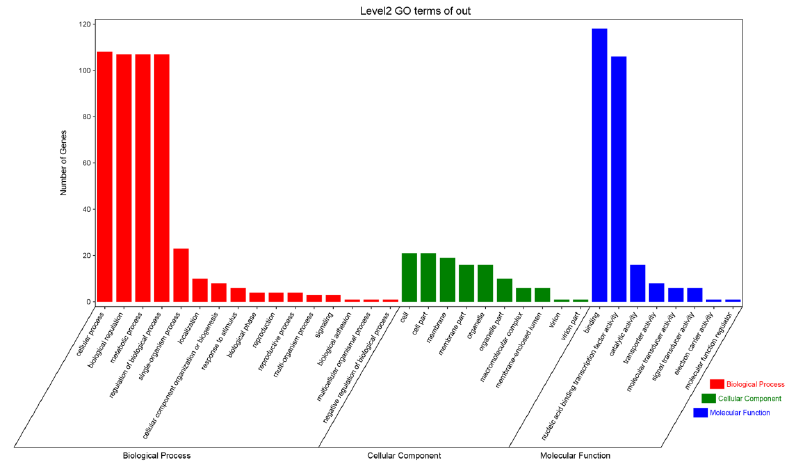
Figure 2. Gene Ontology (GO) enrichment of MdWRKY gene family. Table 1. Significantly differentially expressed MdWRKY TFs with different interstocks.